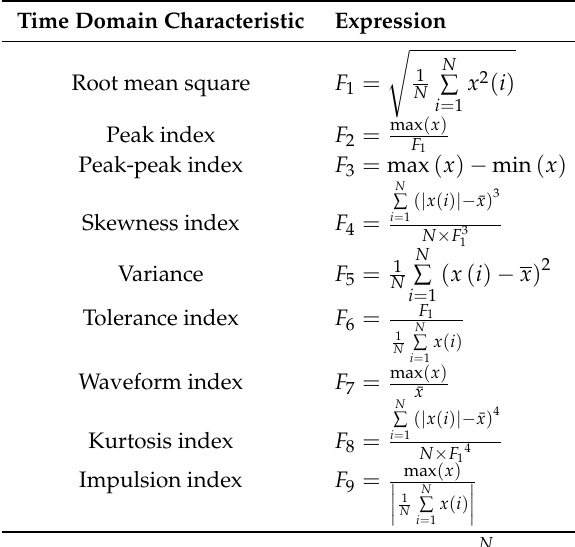
Table 2. Numerical explanation of time